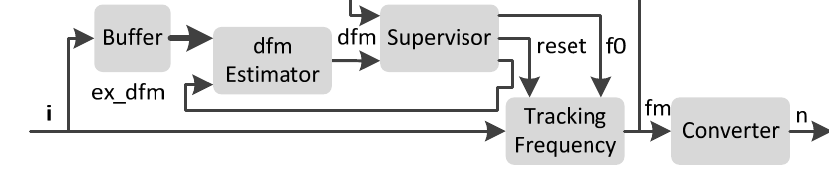
Figure 3. Block diagram of the proposed speed detection method.